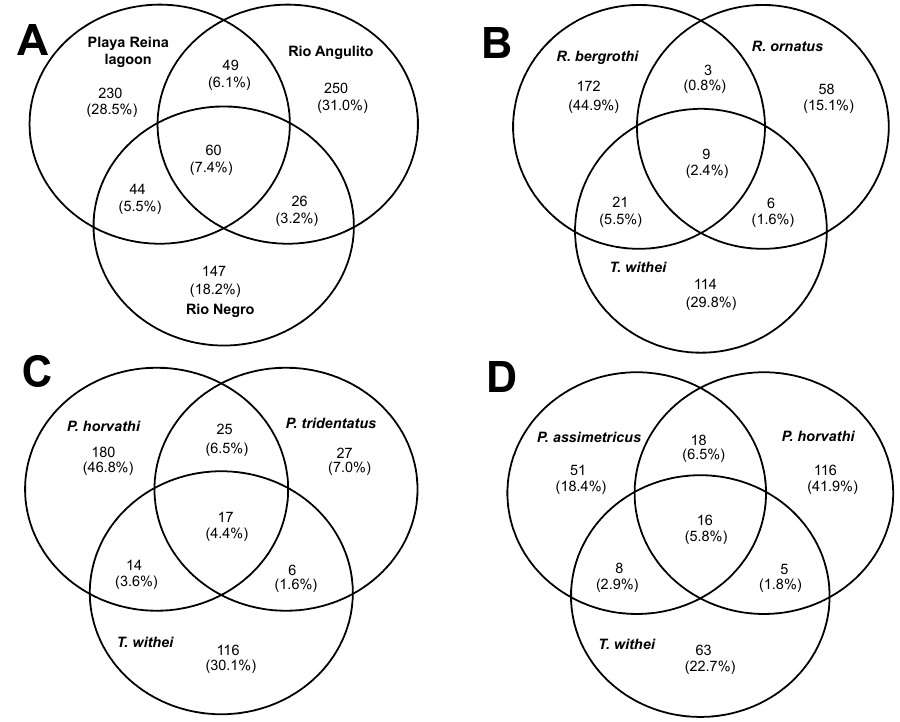
Figure 4. Distribution of bacteria amplicon sequence variants (ASVs) associated with water striders. Venn diagrams show the number (whole values) and proportion (in parenthesis) of unique and shared ASVs among sites ( A ) and species with sites, including Playa Reina lagoon ( B ), Río Angulito ( C ) and Río Negro ( D ).